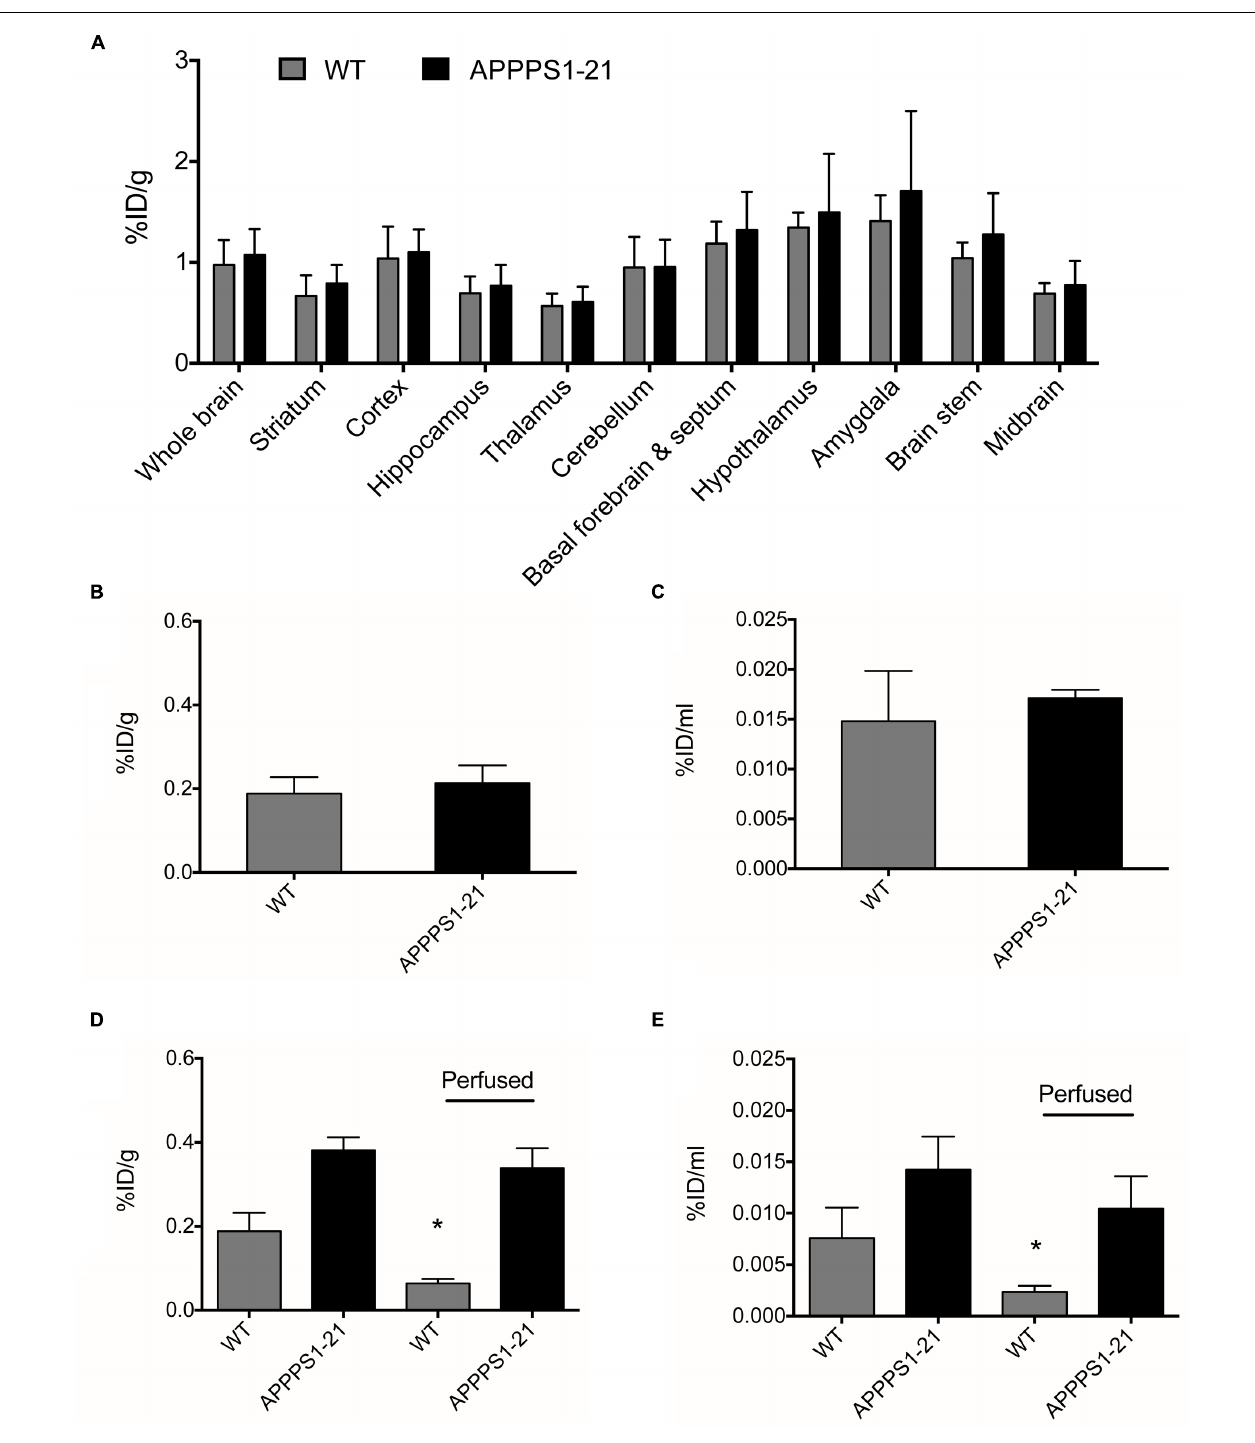
FIGURE 4 | APPPS1–21 mice did not exhibit significant uptake of a non-amyloid targeted antibody in comparison to WT mice. Mice received an i.v injection of 133 µ g of [ 89 Zr]-trastuzumab and were underwent µ PET scanning at 4 days pi. Graph (A) depicts VOI analysis of [ 89 Zr]-trastuzumab retention in WT and APPPS1–21 mice, data is presented as mean + SD. After scanning, mice were sacrificed and brain radioactivity of [ 89 Zr]-trastuzumab was measured by (B) γ –counting and (C) autoradiography. No significant differences in cerebral [ 89 Zr]-trastuzumab retention between genotypes were observed with either in vivo or ex vivo methods. We compared brain retention of [ 89 Zr]-Df-Bz-JRF/A β N/25 in APPPS1–21 with and without transcardial perfusion by (D) γ –counting and (E) autoradiography, data is presented as mean + SD. Student’s t -test ∗ p < 0.05. Retention of [ 89 Zr]-Df-Bz-JRF/A β N/25 was significantly reduced in perfused WT but not perfused APPPS1–21